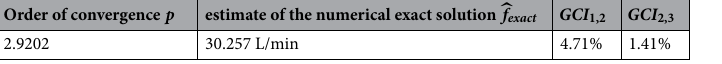
Order of convergence